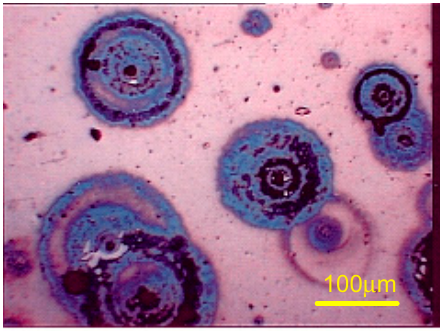
Figure 11. Corrosion pits revealed as blue discs (cross section sample #2).